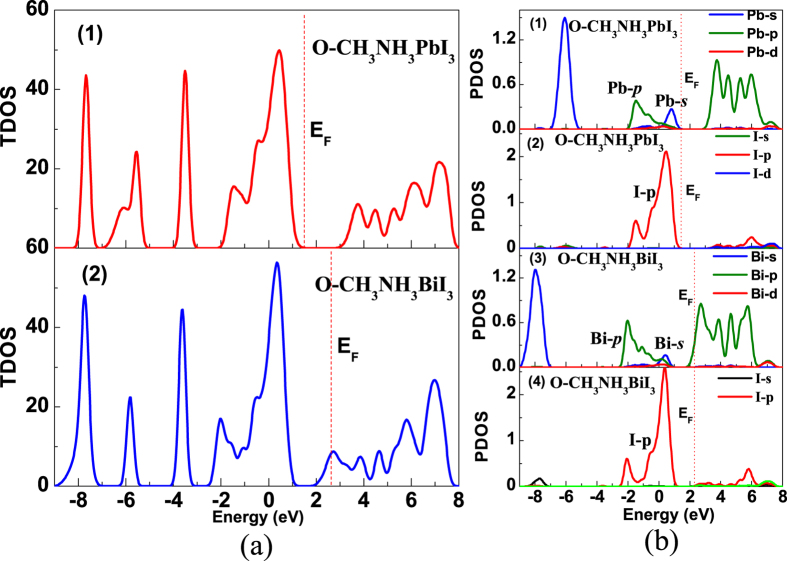
Calculated density of states of O-CH3NH3PbI3 and O-CH3NH3BiI3, (a) TDOS, (b) PDOS. The red dashed lines represent the Fermi level.